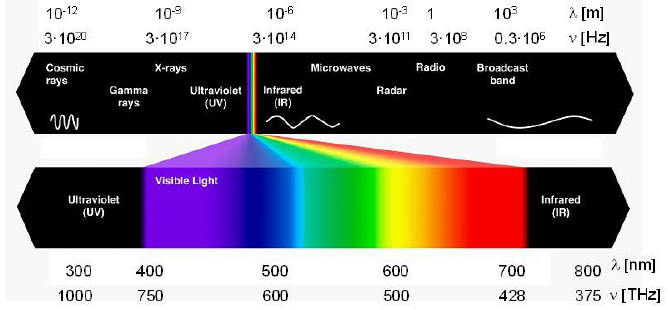
Figure 2. Electromagnetic spectrum [31].